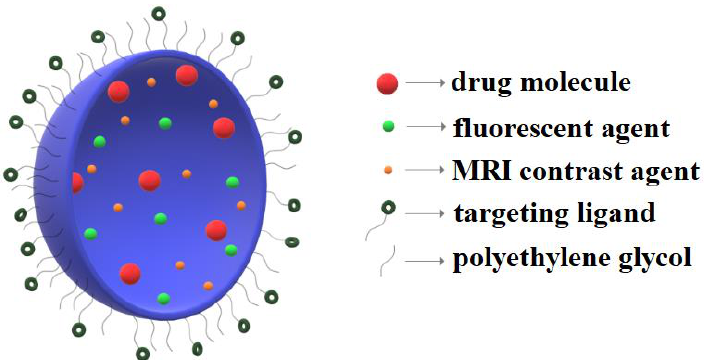
Figure 2. A schematic diagram of the strategies for molecule incorporation and surface functionalization of nanocarriers for neuroimaging.